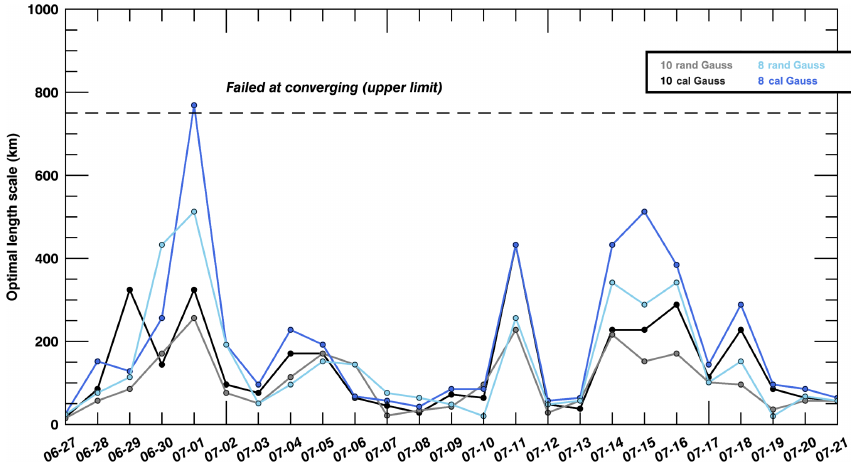
Figure 11. Length scale (in km) of the Gaussian variance filter for 10-member random (in gray) and calibrated (in black) ensembles, and 8-member random (in light blue) and calibrated (royal blue) ensembles, for in situ CO 2 mole fractions at about 100ma.g.l. using Gaussian equations from 27 June to 21 July 2008.